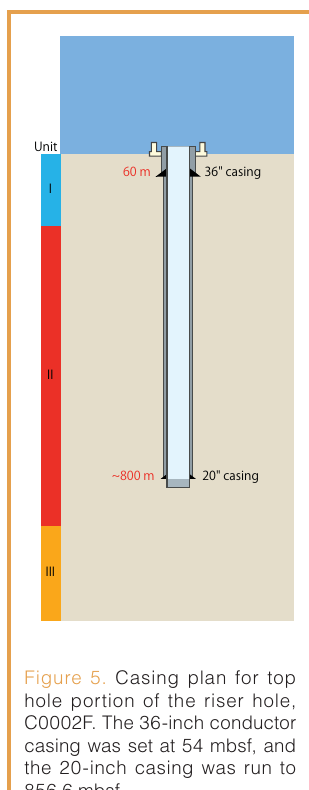
Figure 5. Casing plan for top hole portion of the riser hole, C0002F. The 36-inch conductor casing was set at 54 mbsf, and the 20-inch casing was run to 856.6